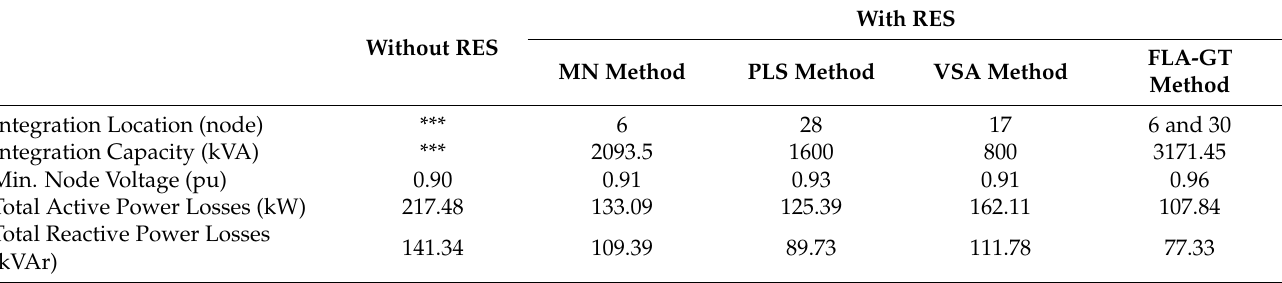
Table 5. Results of article [32] used for